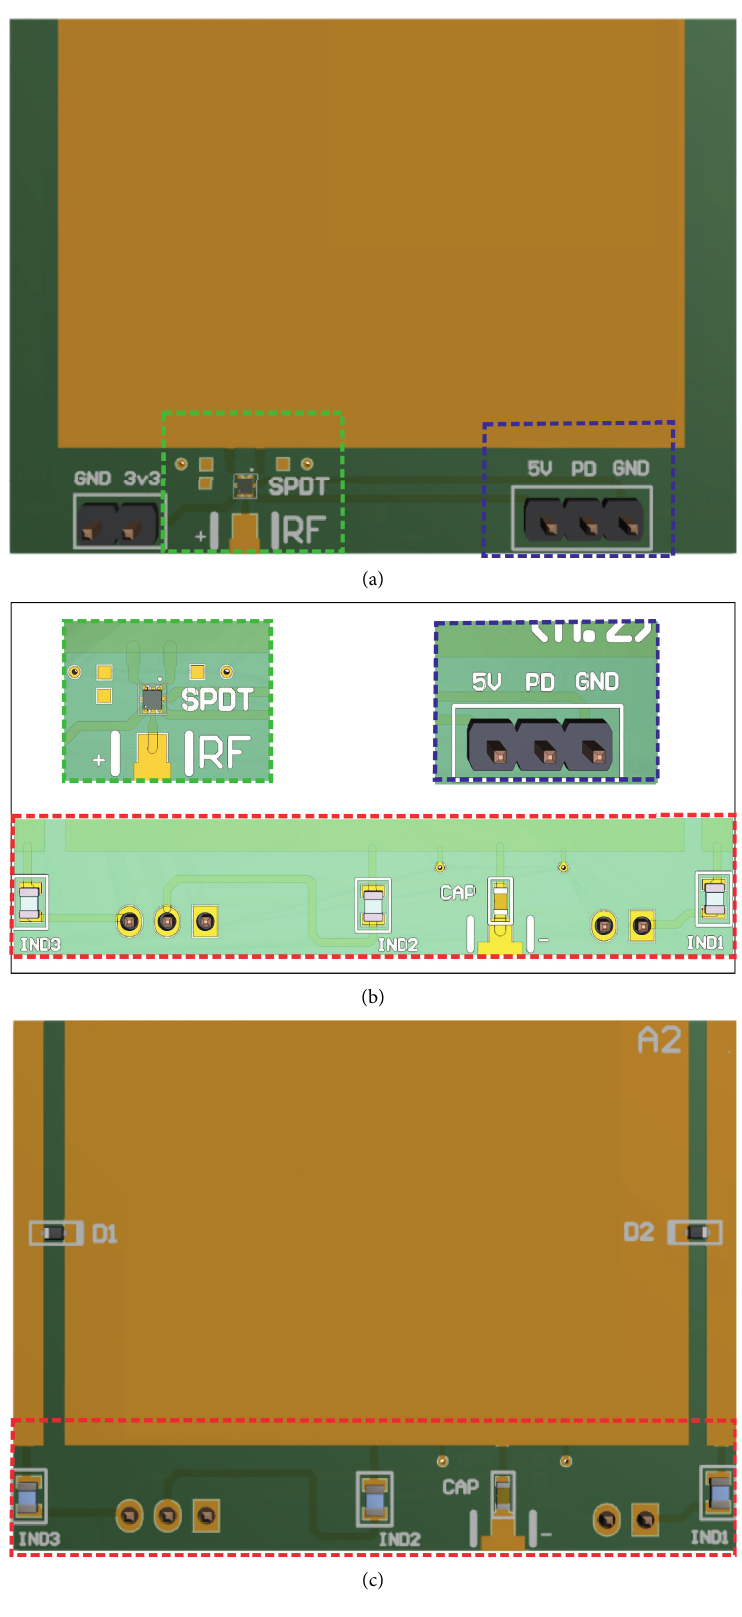
Figure 9: (a) Antenna’s top view, (b) bias circuit areas, and (c) antenna’s back